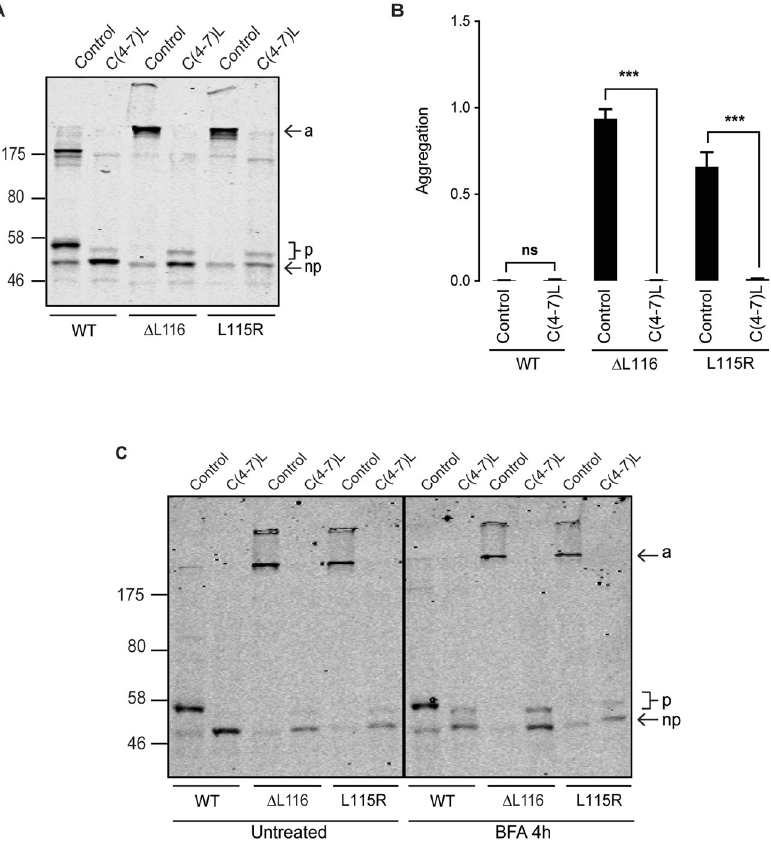
Figure 4. C(4-7)L substitutions block aggregation of the ANCL mutants. EGFP-CSP α wild-type and Δ L116/ L115R constructs with or without C(4-7)L substitutions were transfected into PC12 cells for 48 hours and subsequently analysed by immunoblotting with anti-GFP ( A ). The non-palmitoylated monomers ( np ), palmitoylated monomers ( p ) and aggregates ( a) are marked by arrows. The position of molecular marker is shown on the left hand side. Averaged data of the aggregate to monomer + dimer ratio (n = 4) is shown together with SEM ( B ). Statistical significance was assessed using an unpaired Student T test, asterisks denote a significant difference compared with the control (wild-type, Δ L116 or L115R) CSP α construct ( *** p < 0.001 ). ( C ) PC12 cells transfected with the wild-type and mutant EGFP-CSP α constructs with or without the C(4-7) L substitutions were treated with 30 µ g/ml of BFA for 4 hours. The samples were then resolved by SDS-PAGE and transferred to nitrocellulose for immunoblotting analysis using an antibody against GFP. The untreated and BFA-treated samples that are shown are from the same immunoblot but with intervening gel lanes removed and this is indicated by the solid black